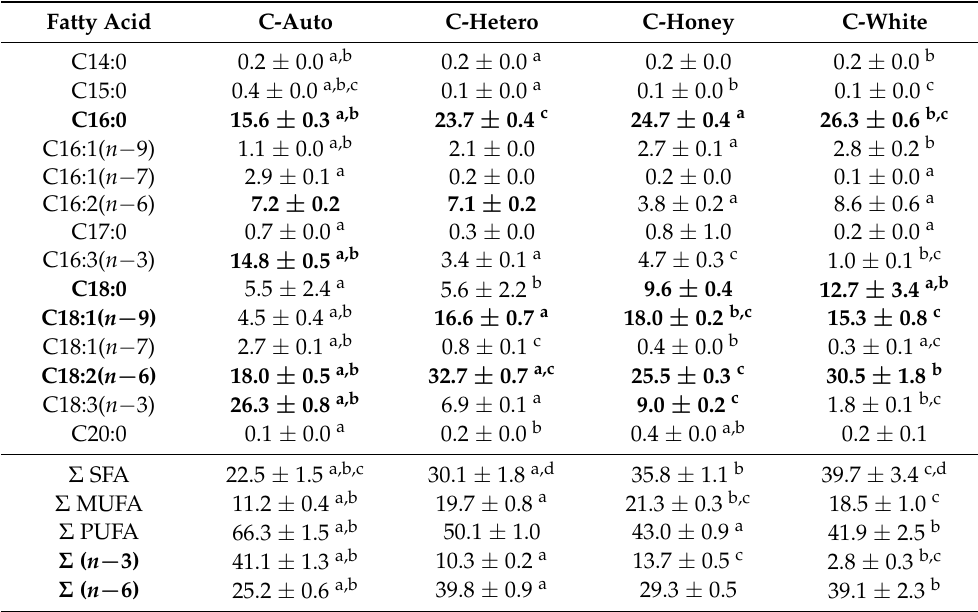
Table 1. GC-MS analysis of the fatty acid composition (in %) of total lipid extract from the four C. vulgaris strains (C-Auto, C-Hetero, C-Honey, and C-White). Data are presented as mean ± SD ( n = 5). The most abundant FAs are highlighted in bold. Values with the same letter ( a , b , or c ) are statistically different ( q < 0.05).